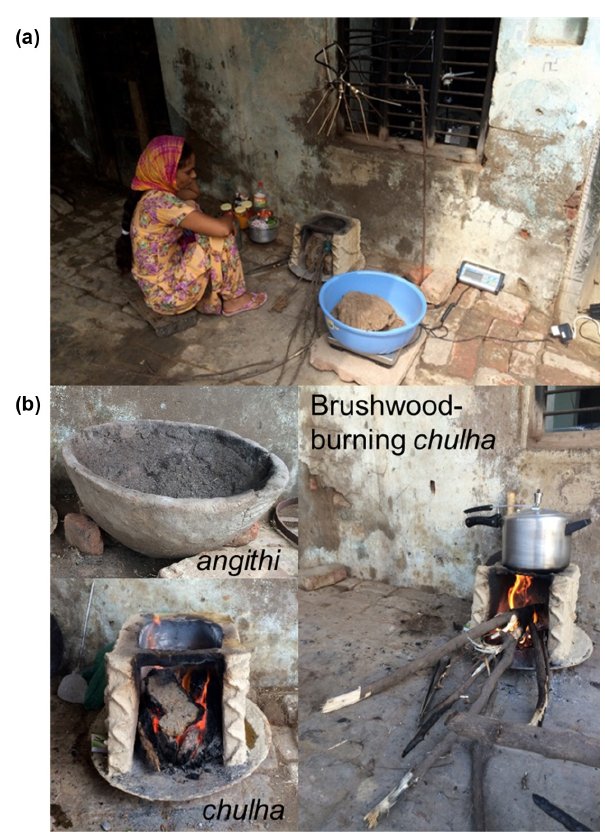
Figure 1. The field site and setup for cooking events. (a) The kitchen setup at the field site. (b) The stoves and fuels used in this study: angithi , dung-burning chulha , and brushwood-burning chulha